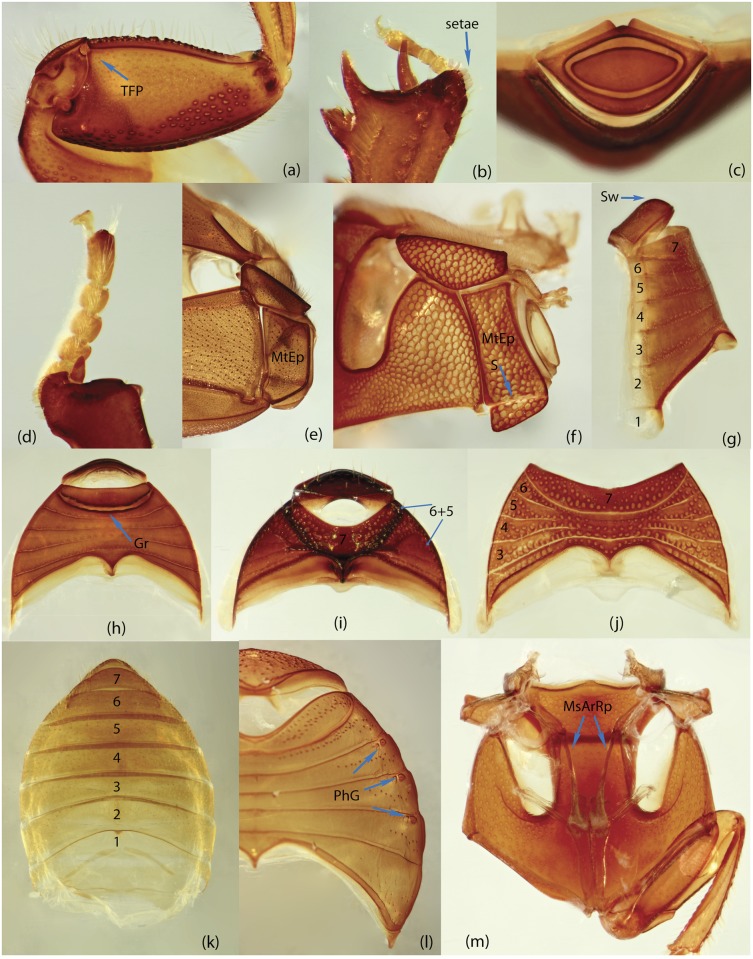
Morphological structures of Scarabaeinae.a, Coptodactyla glabricollis; b, Boletoscapter cornutus; c, Bdelyropsis bowditchi; d, Pseudonthobium sinuatotibiale; e, Paragymnopleurus sp.; f, Coptorhina auspicata; g, Ochicanthon sp.; h, Bdelyropsis bowditchi; i, Trichillum pauliani; j, Paraphytus sp.; k, Podotenus fulviventris; l, Pachysoma aesculapius; m, Agamopus viridis; a, femur and trochanter of foreleg; b, apical portion of fore tibia, lamella-like setae arrowed; c, pygidium; d, fore tarsus; e, f, pterothorax, lateral view; g, abdomen, lateral view, sternites enumerated; h-l, abdomen ventral view, sternites partly enumerated; m, internal structure of pterothorax, dorsal view.